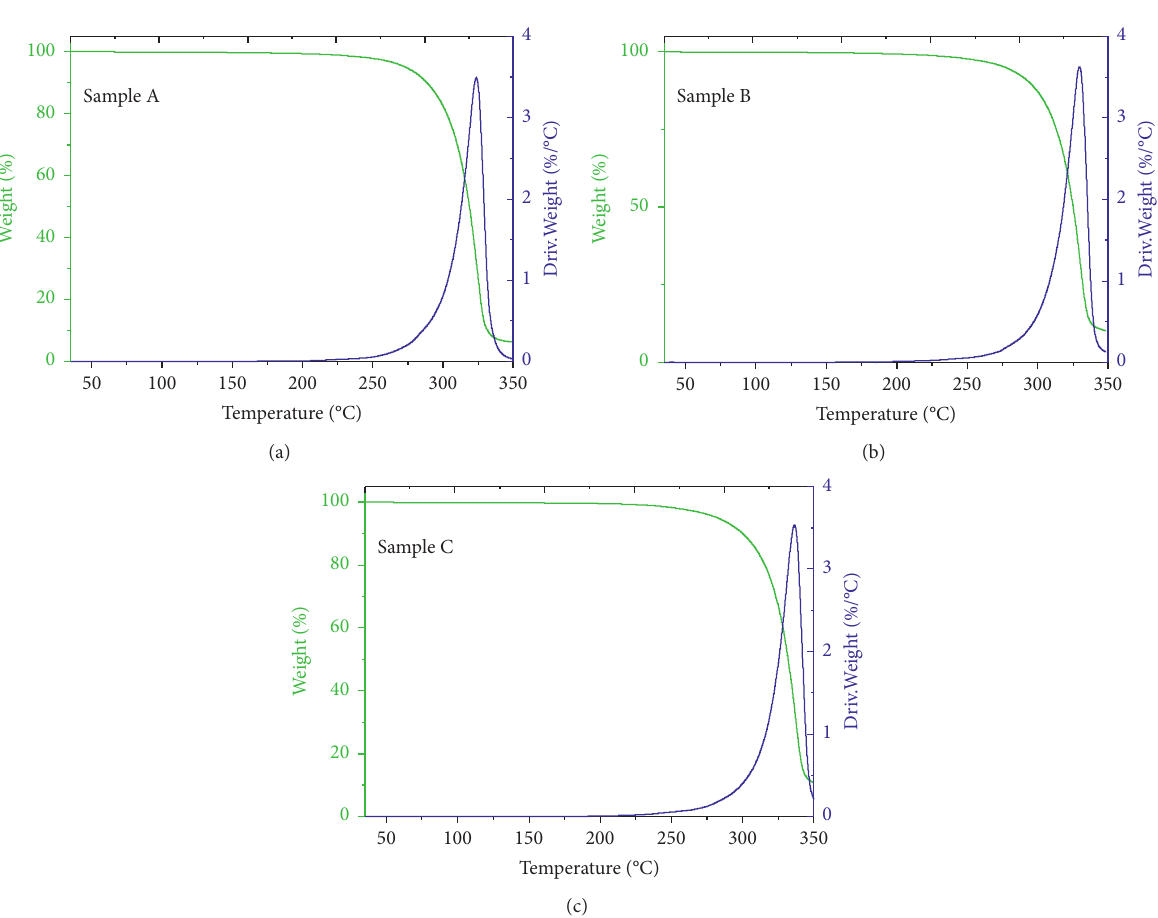
Figure 5: The TGA curves of the spray-dried samples A, B, and C (from left to